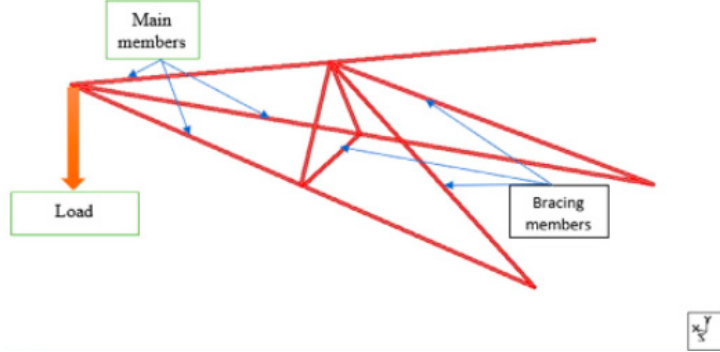
Figure 14. Final design of bracing cross arm in 132 kV transmission tower [110].